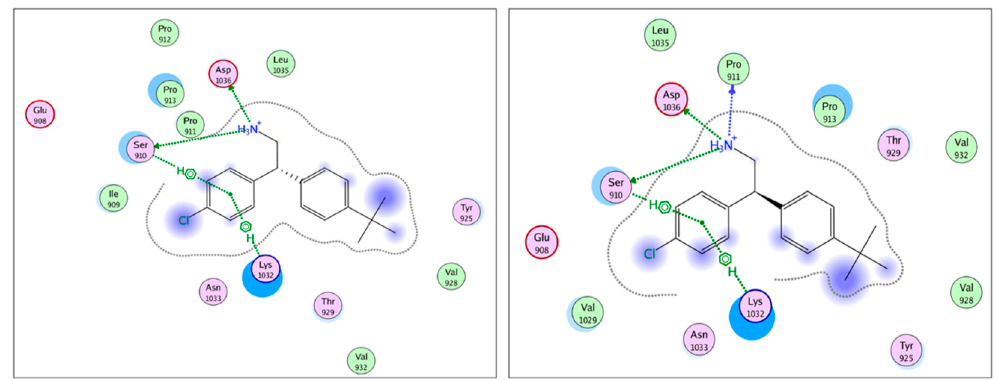
Figure 4. The predicted binding mode of the two enantiomers of compound I showing similar interactions with the FAK-FAT domain; hydrogen bond is indicated by the dashed lines.